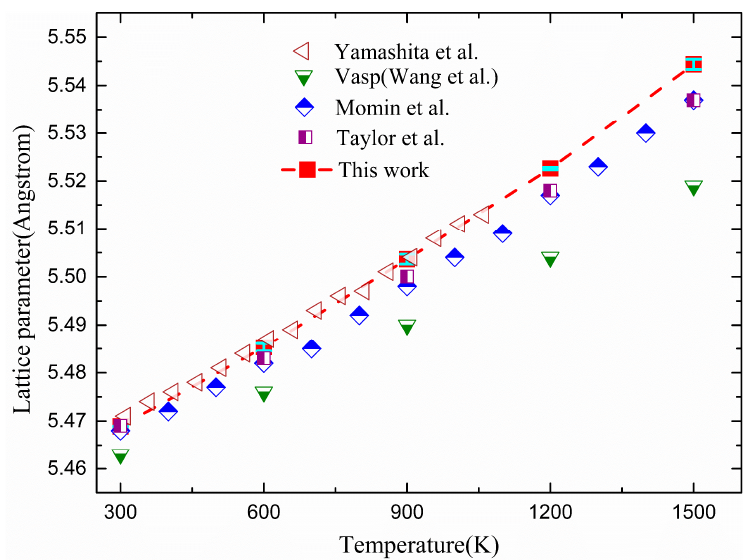
Figure 1. Dependence of lattice constant on temperature including the results from the present work, the experiment studies by Taylor et al. [27], Momin et al. [29], Yamashita et al. [28], and the VASP results by Wang et al.